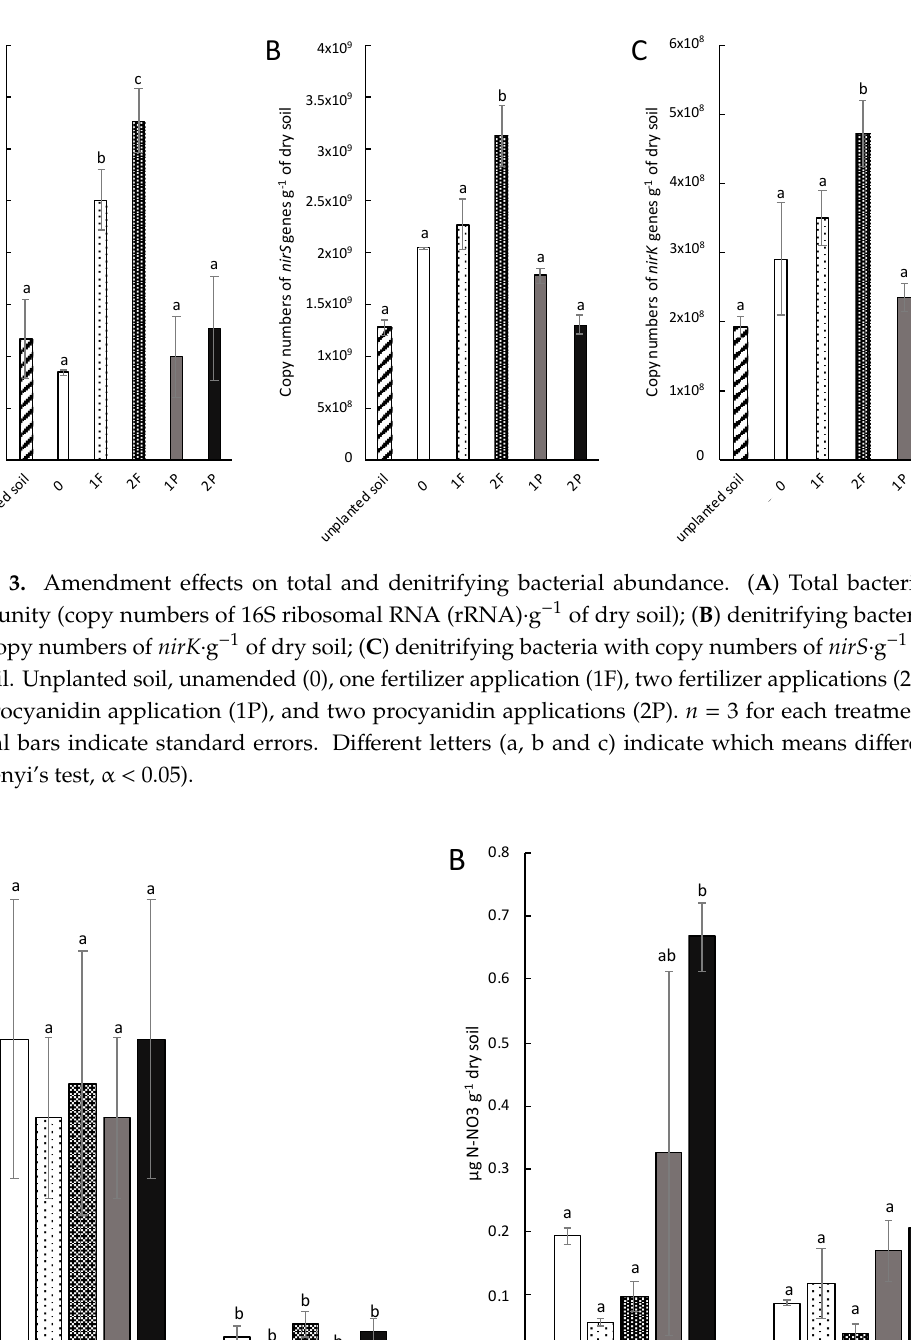
Figure 4. E ff ects of di ff erent types of amendments with procyanidins or fertilizers on soil nitrate level of unplanted soils and soils planted with celery: ( A ) for T0 before procyanidins or fertilizers amendments and ( B ) for TF corresponding to the day of harvest. Unamended (0), one fertilizer application (1F), two fertilizer applications (2F), one procyanidin application (1P), and two procyanidin applications (2P). n = 3 for each treatment. Vertical bars indicate standard errors. Di ff erences in letters (a, b and ab) indicate a di ff erence in treatment (Nemenyi’s test; α <